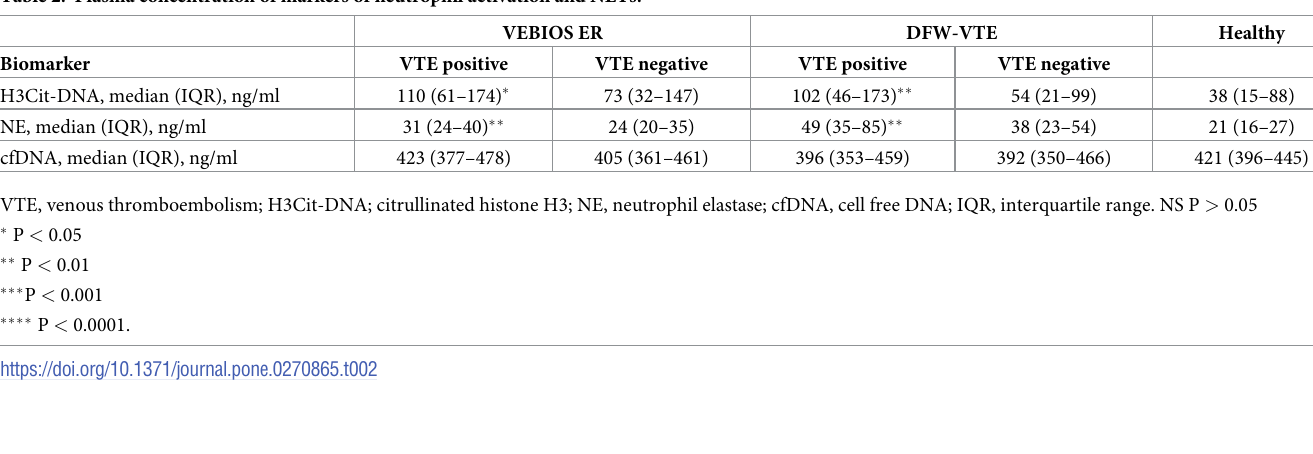
Table 2. Plasma concentration of markers of neutrophil activation and NETs.